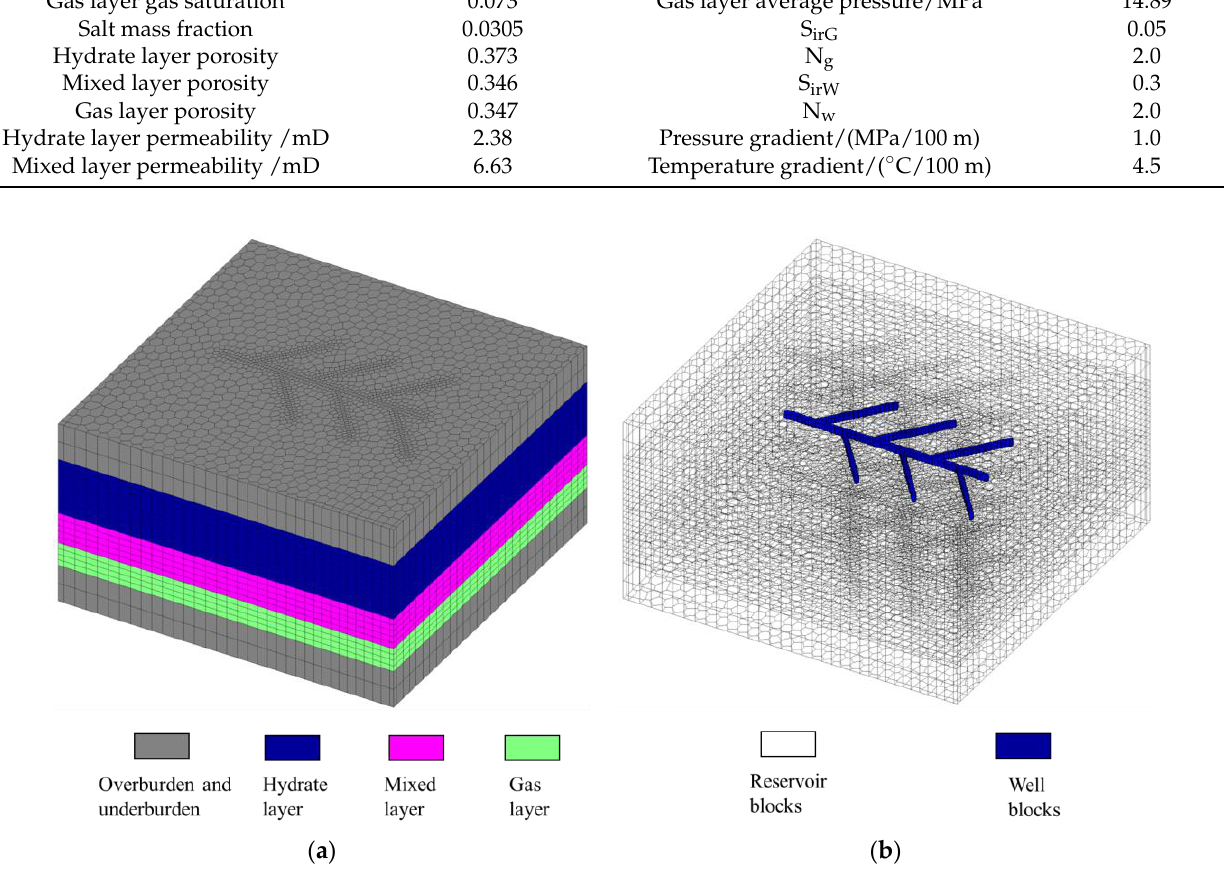
Figure 3. ( a ) Reservoir and well location setting, ( b ) six-branch fishbone well. Well location setting and 3D grid generation.